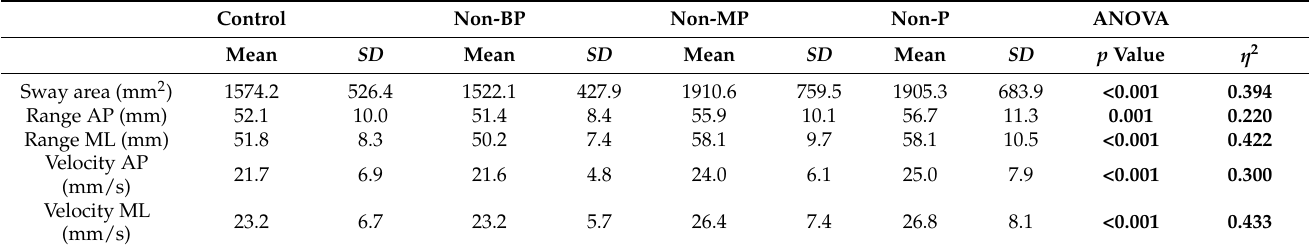
Table 1. Results of postural stability measures using ANOVA.